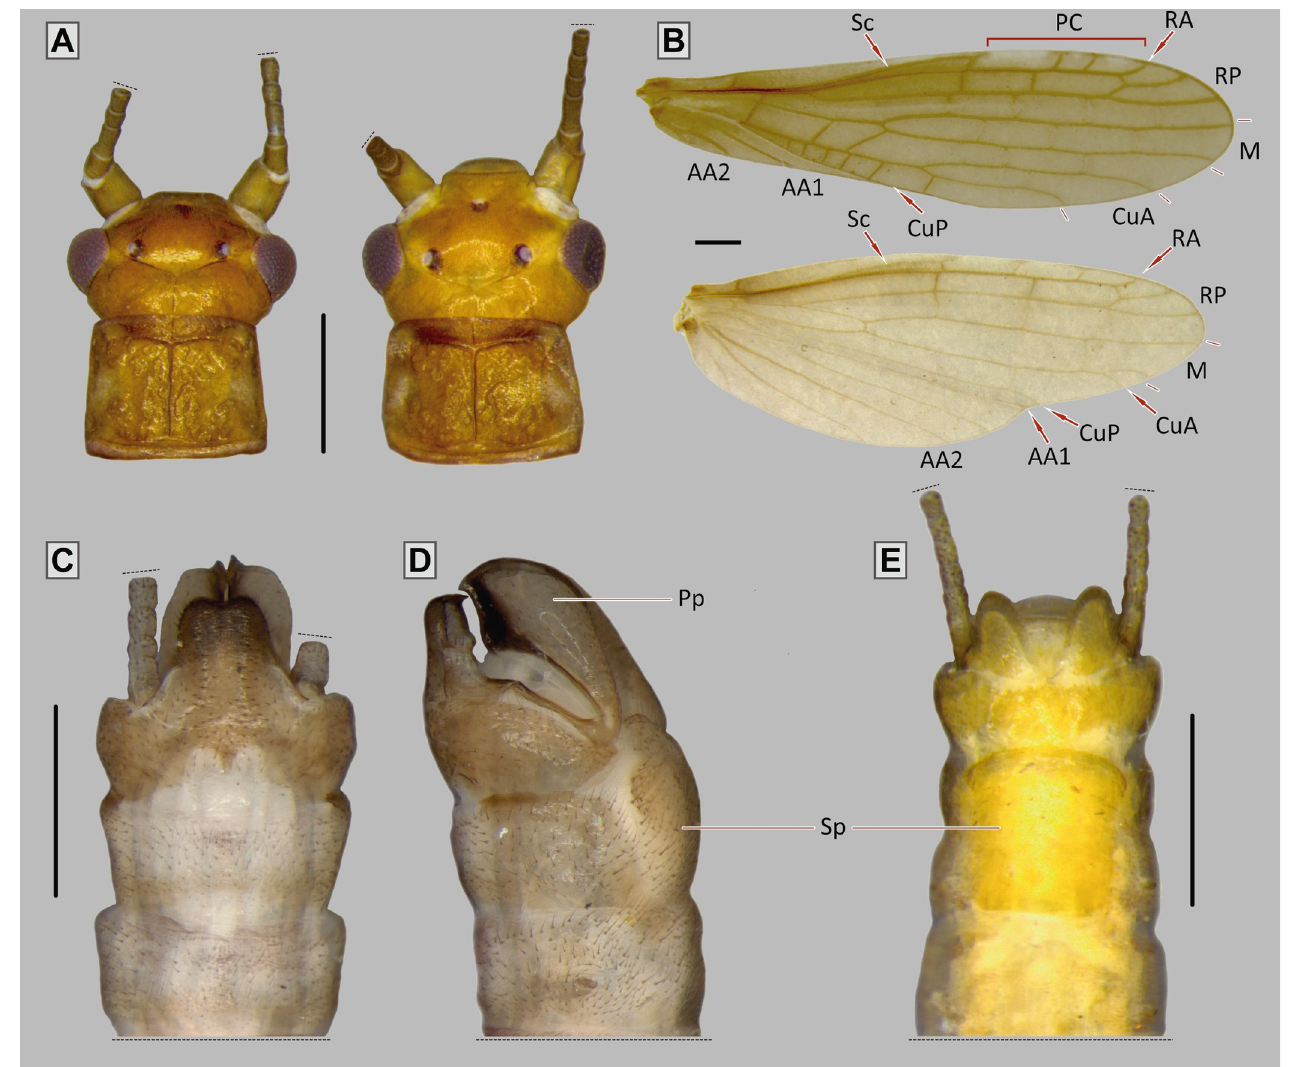
Fig 6. Paragripopteryx ogum sp. nov. (A) Left–holotype adult male, head and pronotum in dorsal view; right–female head and pronotum in dorsal view. (B) Male fore- and hind wings. (C , D) Male terminalia in dorsal and lateral views, respectively. (E) Female, terminalia in ventral view (Scale bars: A, B, E: 0.5 mm; C, D: 0.4